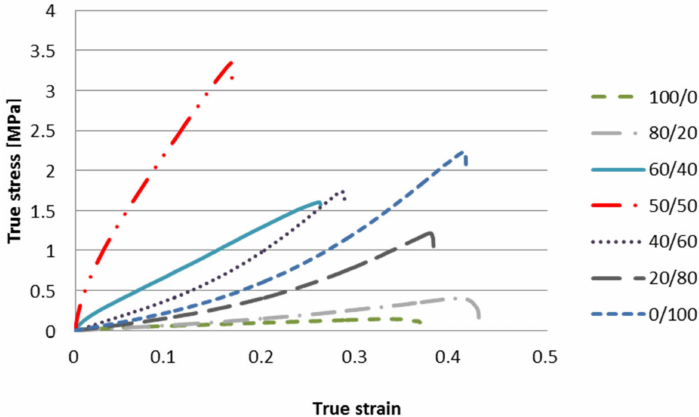
Figure 9. Typical true stress versus true strain curves of CMS / CMC